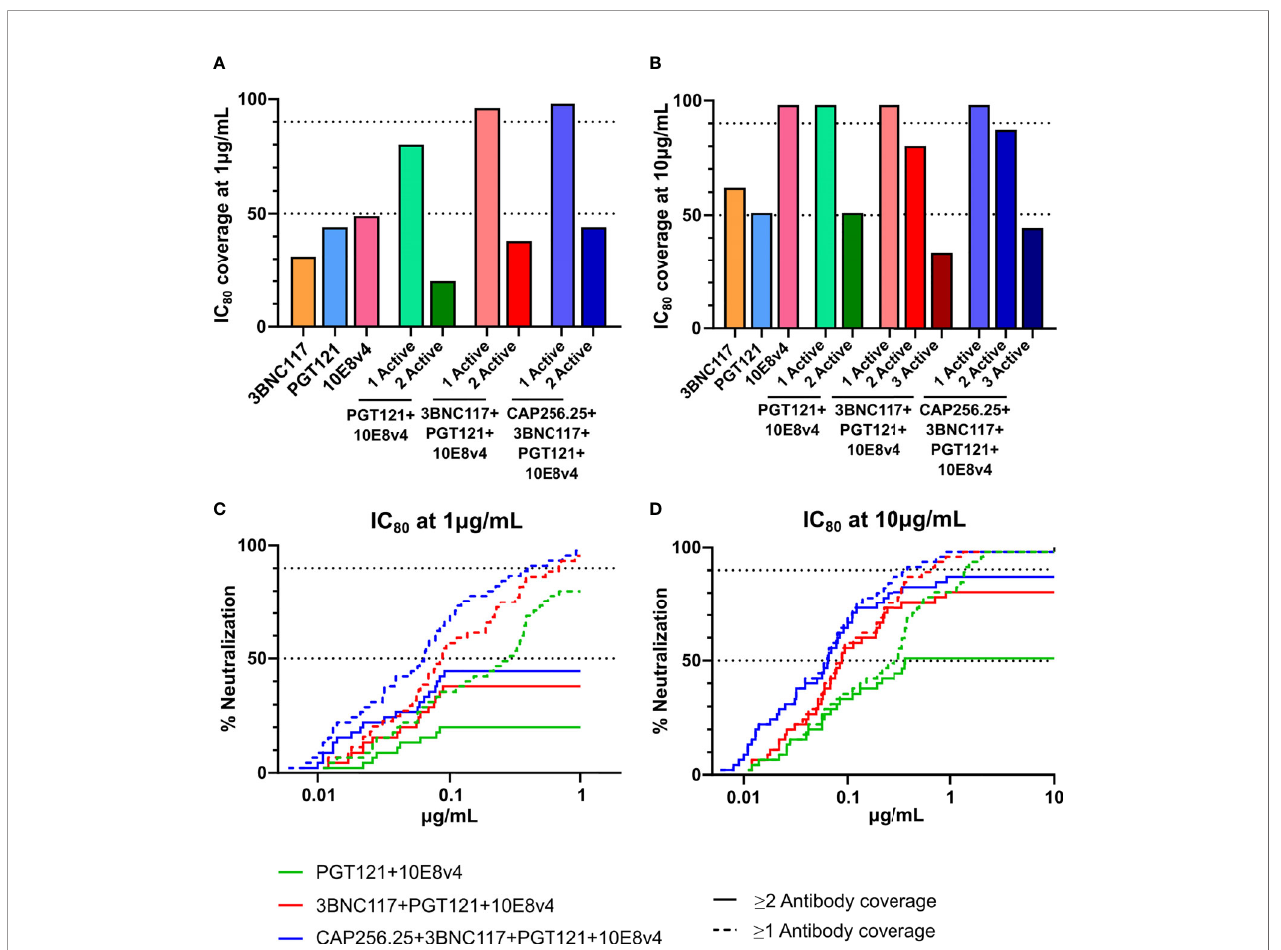
FIGURE 7 | Predicted coverage and estimated ef fi cacy of best scFv combinations. (A, B) Active coverage by one, two, three or four scFv was calculated at 2 concentrations (1 m g/mL (A) and 10 m g/mL (B) at IC 80 based on the predicted titers according to the Bliss-Hill Independence model. The broadest triple and quadruple combinations are shown. (C, D) Breadth Potency curves of active coverage of 1 and 2 scFv are given for the best combinations (3BNC17+10E8v4 and 3BNC17+10E8v4+PGT121, and CAP256.25+3BNC17+10E8v4+PGT121) at 1 m g/mL (C) and 10 m g/mL (D) . 50% and 90% breadth are indicated by the dotted lines in (C, D)